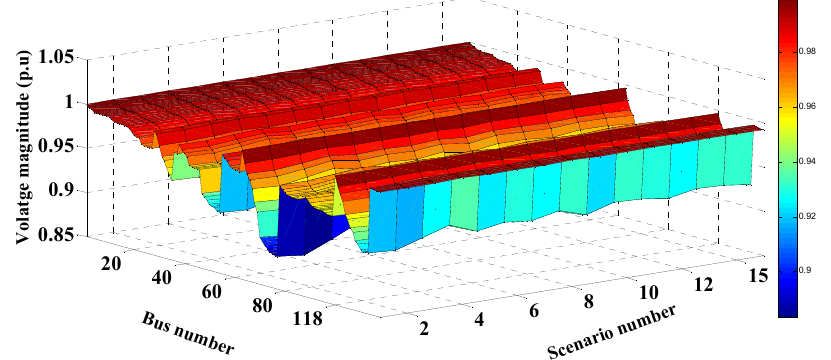
Figure 12. Bus voltage magnitudes of the IEEE 118-bus system without RERs.